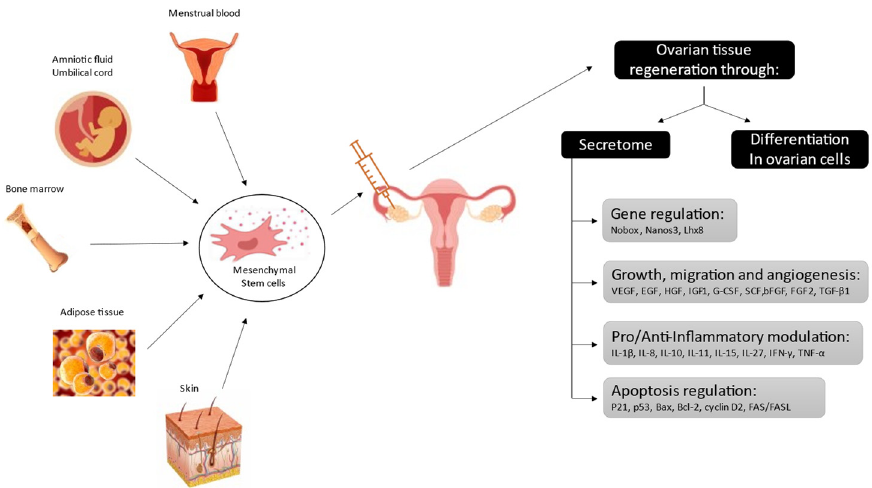
Figure 2. Origins of mesenchymal stem cells that have been tested in preclinical studies using premature ovarian insufficiency models, along with their potential mechanism of action in restoring fertility (adapted from Ahmadian S et al.,